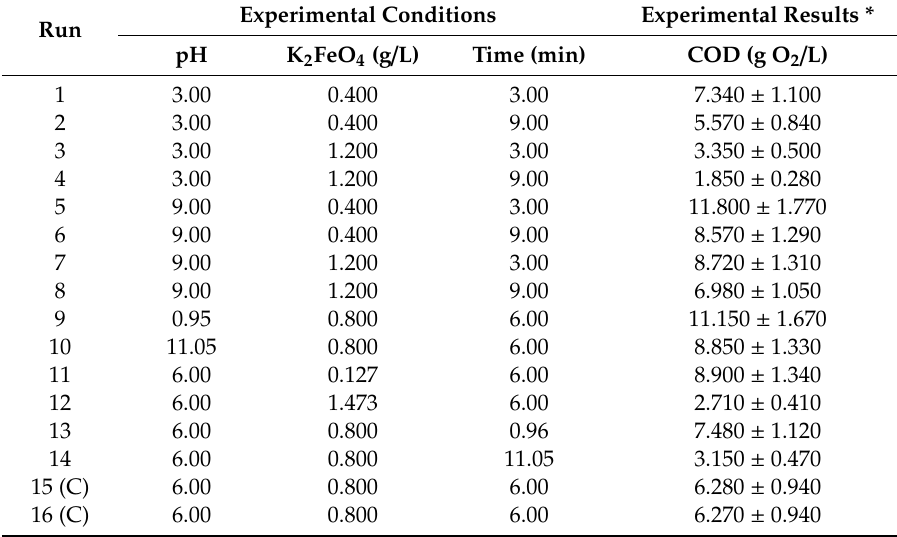
Table 3. Experimental conditions for the RSM and results (COD) for tannery wastewater (K 2 FeO